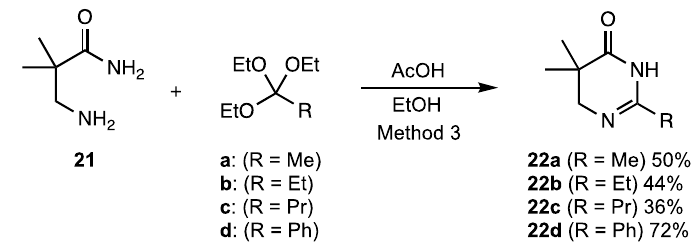
Figure 2. Mechanism for quinazolin-4(3 H )-one